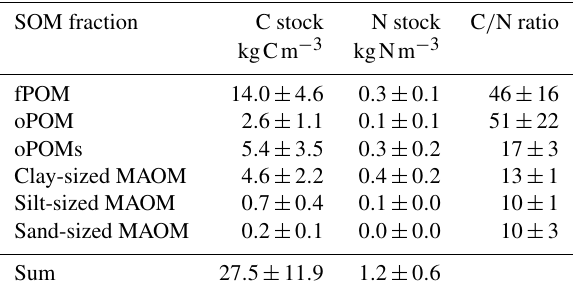
Table 1. C and N stocks (projected to 1m soil depth) and C / N ra- tios of the SOM fractions. Given are mean values and the standard deviation of free (fPOM), occluded (oPOM) and small occluded (oPOMs) particulate organic matter and of different-sized mineral- associated organic matter (MAOM).